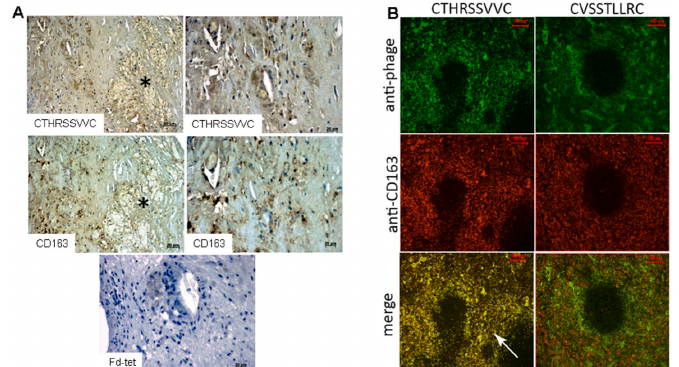
Figure 2. CD163 expression and CTHRSSVVC-phage overlay by different assays co-localize in atheroma and spleen tissues. ( A ) CTHRSSVVC-phage overlay localization and expression of CD163 in atherosclerotic tissue particularly in areas rich in macrophages (indicated by the star (*)). Phages bound to tissue were revealed using an anti-bacteriophage antibody. No significant staining was observed with the insertless phage Fd-tet. Bar, 50 µm ( left panels) and 20 µm ( right panels); ( B ) CTHRSSVVC (CD163-mimic) or CVSSTLLRC (PlGF-mimic) phage localization ( green ) and CD163 expression ( red ) in spleen tissue observed by immunofluorescence and visualized by confocal microscopy. Phages bound to tissue were revealed using an anti-bacteriophage antibody. The bottom panels show the merge of the phage overlay ( upper panels) and CD163 expression ( middle panels). Bright yellow (as exemplified by the arrows) indicates co-localization. Note that the co-localization with CVSSTLLRC-phage was not as complete as with the other peptide. Bar, 100 µm in all panels.